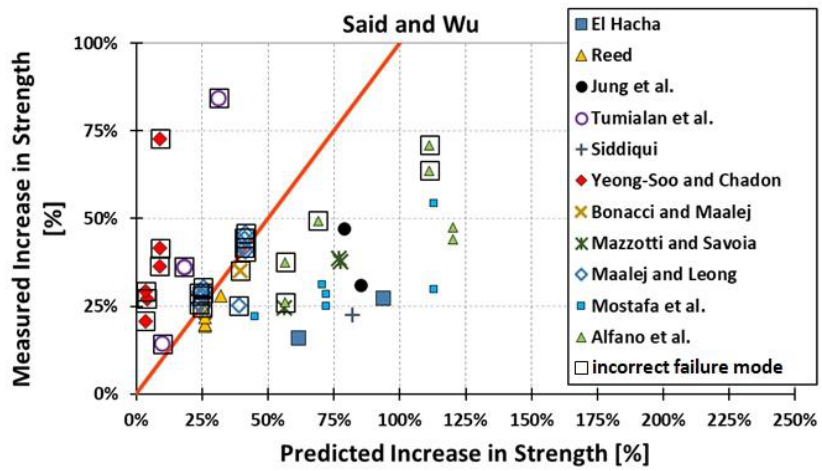
Figure 15. Measured increase in flexural strength versus Seracino et al. model prediction.